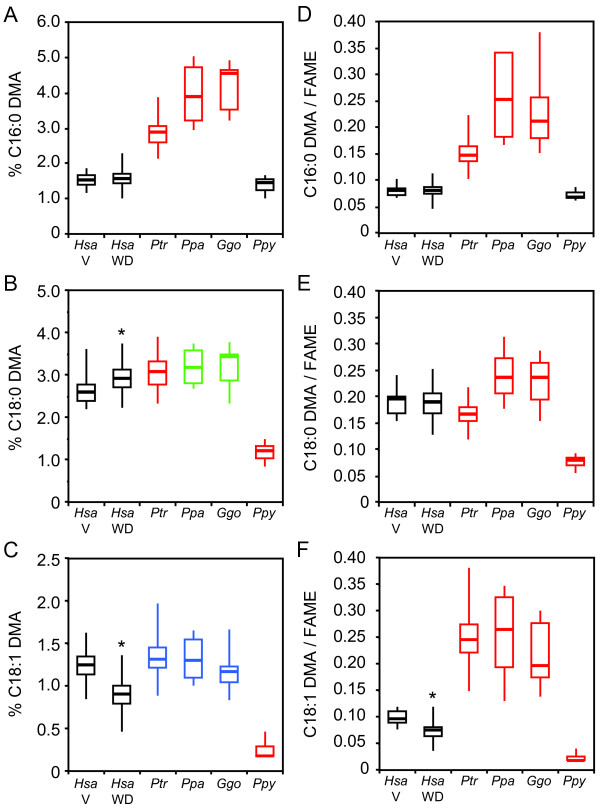
Human and great ape RBC plasmalogen composition. On the left most panels, we provide modified box plots representing the percentage of the DMA derivatives of (A) C16:0, (B) C18:0, and (C) C18:1 chemical moieties present in the sn-1 position of plasmalogens relative to total fatty acids (Y-axis) in RBCs. On the rightmost panels, we provide modified box plots representing the ratio of the abundance of (D) C16:0, (E) C18:0, and (F) C18:1 chemical moieties present in the sn-1 position of plasmalogens with respect to their cognate fatty acids (Y-axis) in RBCs. These are reported as DMA/FAME ratios since the vinyl either-linked groups and cognate fatty acids are converted to dimethyl acetyl (DMA) and fatty acid methylester (FAME) derivatives, respectively, after RBC sample processing. In Panel F, C18:1 FAME levels represent the sum of C18:1 (n-5), C18:1 (n-7), and C18:1 (n-9) FAMEs. C18:1 (n-5) FAME levels could not be measured in one orangutan, consistent with its trace abundance in the other two orangutans. The numbers and identities of RBC donors (X-axis) is the same as in Figure 2. Animal cohort data are color-coded as indicated in Figure 4. The star in Panels B, C, and F indicate that the DMA level or DMA/FAME ratio in the human vegan and Western diet cohort differ (P < 0.05).